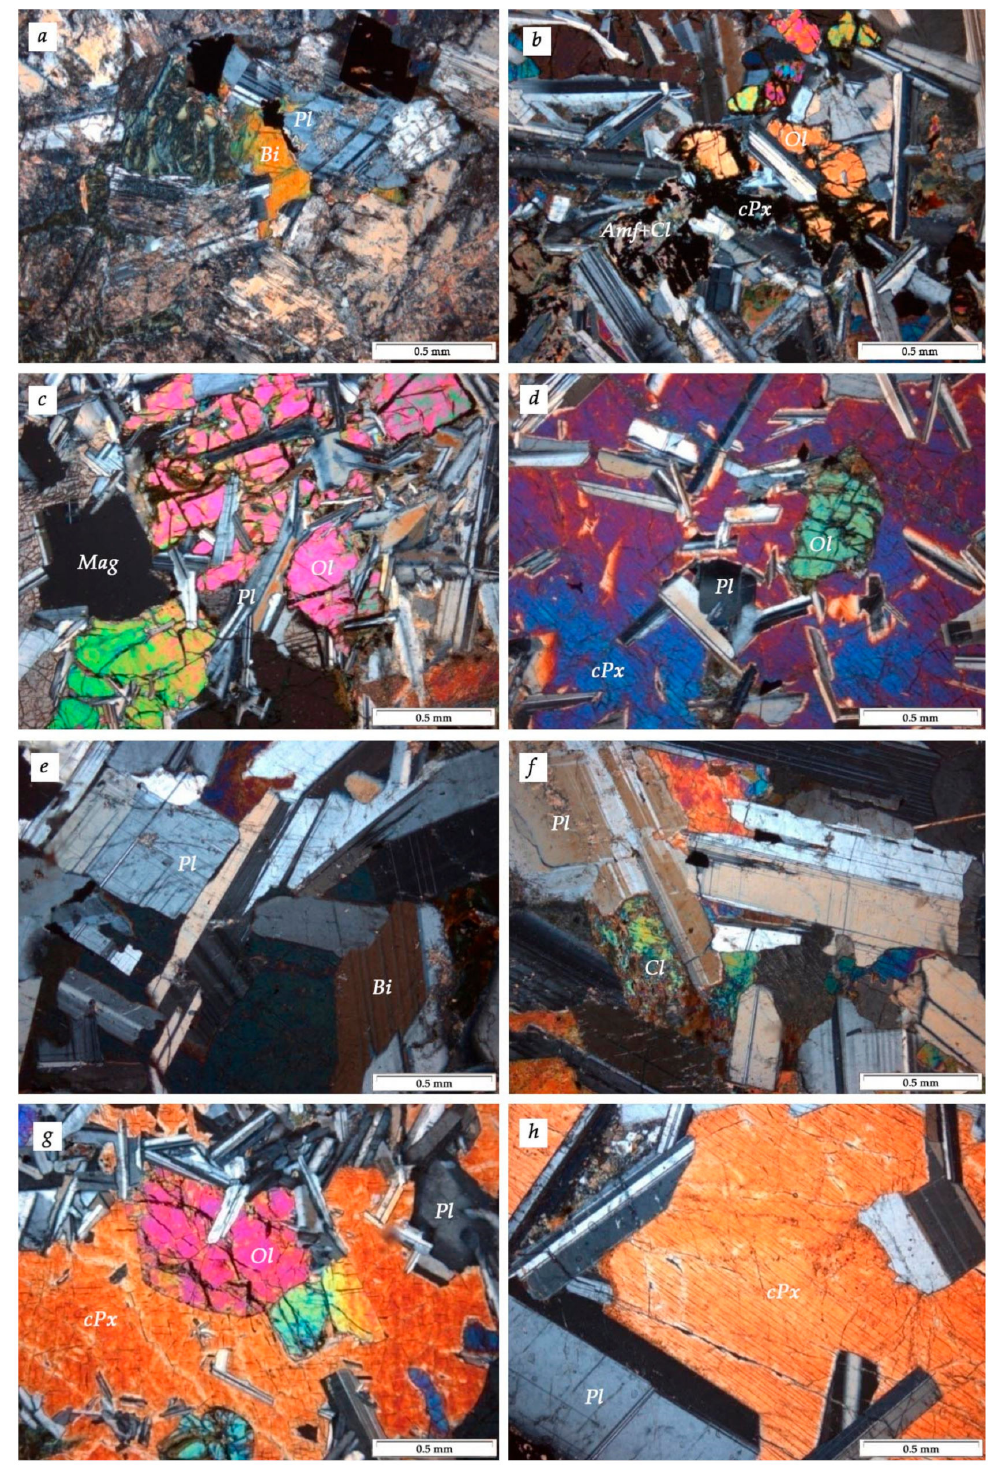
Figure 4. Photomicrographs of the intrusive rocks of the Turumakit area, borehole BT-6 and BT-8. Samples: ( a,b ) BT-6 / 90 biotite-amphibole bearing leucogabbro; ( c,d ) BT-8 / 97.4 olivine-bearing gabbro-dolerite; ( e ) BT-8 / 109 leucogabbro; ( f,g ) BT-8 / 134 olivine-bearing gabbro-dolerite; ( h ) BT-8 / 212 taxitic gabbro-dolerite (see relative position of the samples in the Figure 3); Minerals: Ol —olivine, cPx —clinopyroxene, Pl —plagioclase, Bi —biotite, Mag —magnetite,